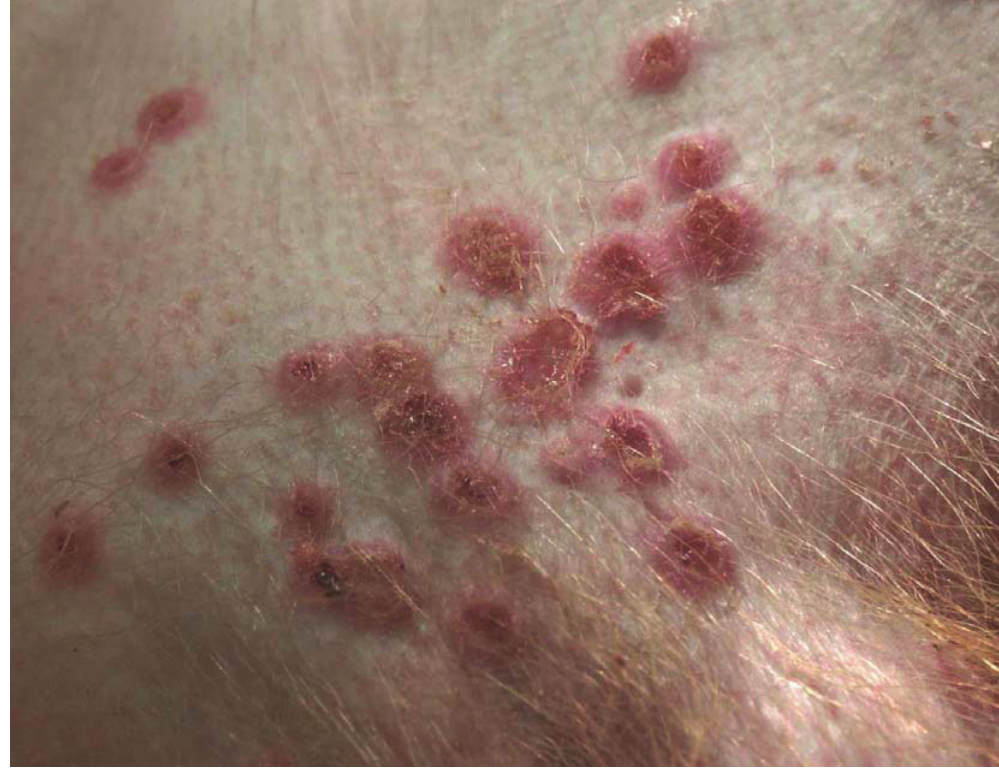
Figure 2. Skin of Monkeypox virus infected M. mulatta with multiple vesicular and erosive to ulcerative skin